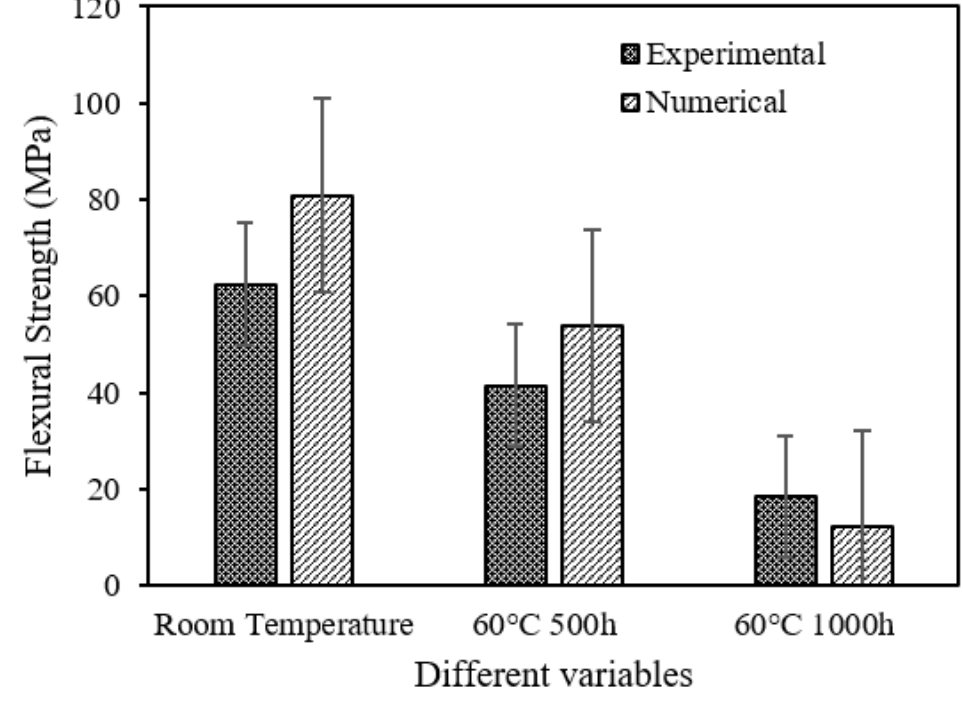
Figure 18. Comparison between the experimental and numerical flexural strength of GFRE. A comparison of the experimental and numerical flexural strengths of the SFRE ob- tained in this study is also shown in Figure 19. There was a slight agreement between these two results with similar behaviour from C1 to C2. In the numerical analysis, there was a decrease of only 15% in the flexural strength from C1 to C2 and a substantial de- crease of 84% under C3. In the experimental studies, however, the flexural strength fluc- tuated slightly but remained almost the same.